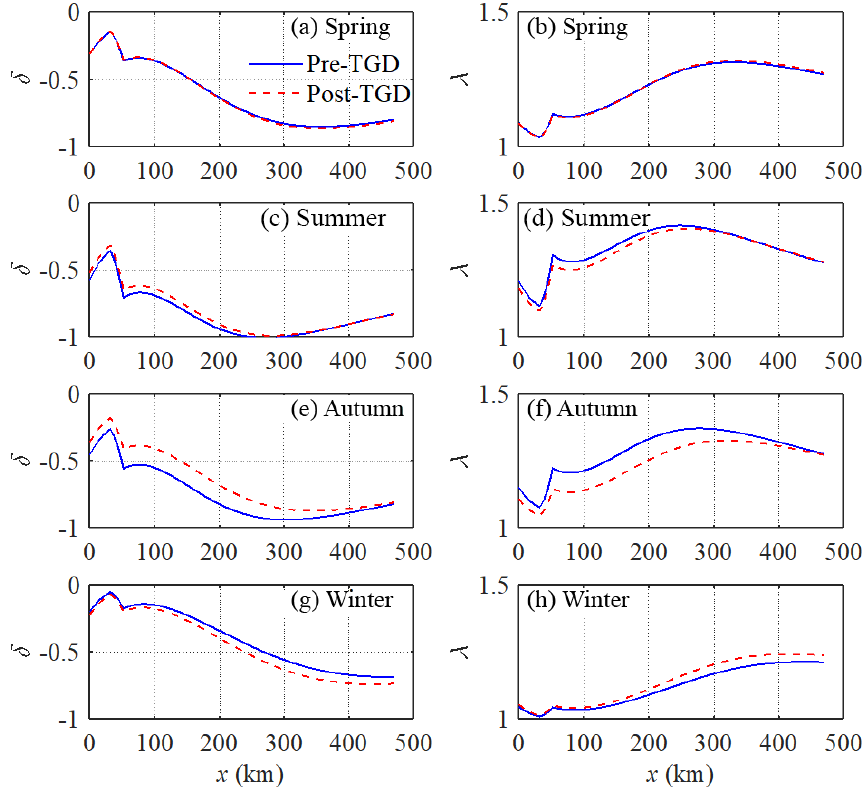
Figure 6. Longitudinal variability of simulated tidal damping number δ (a, c, e, g) and celerity number λ (b, d, g, i) along the Yangtze estuary in different seasons (spring: a, b ; summer: c, d ; autumn: e, g ; winter: g, i ) for both the pre-TGD and post-TGD